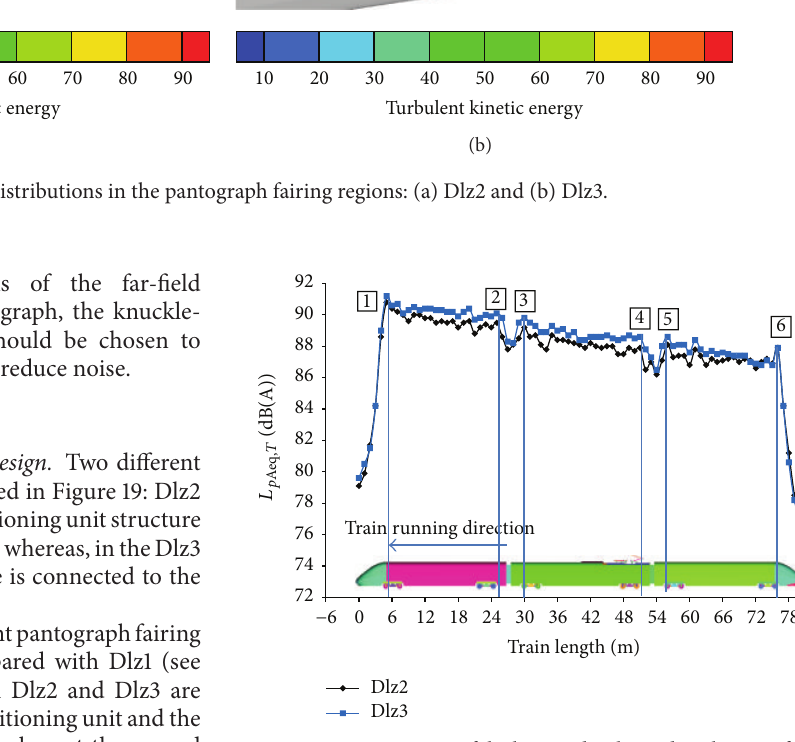
Figure 21: Comparison of the longitudinal SPL distributions for two different pantograph fairing structures. Table6:ComparisonoftheSPLindicesforthedifferentpantograph fairing structures